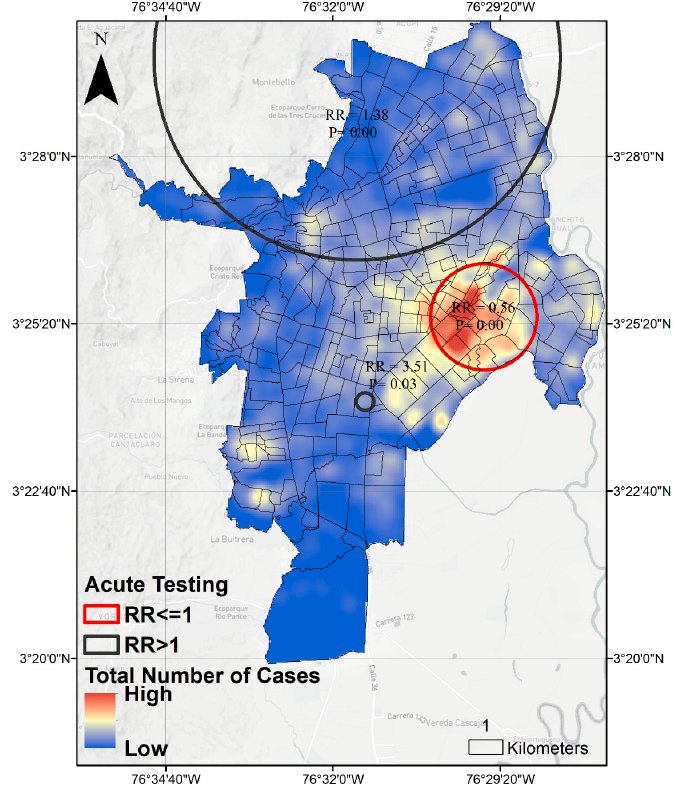
Figure 3. SatScan analysis of acute DENV laboratory testing among all DENV cases reported to SIVIGILA in Cali 2014–2016. RR = Relative Risk calculated as ratio of observed versus expected number of cases having lab confirmation of acute infection compared to no lab confirmation or non-acute lab diagnosis in urban area of Cali,